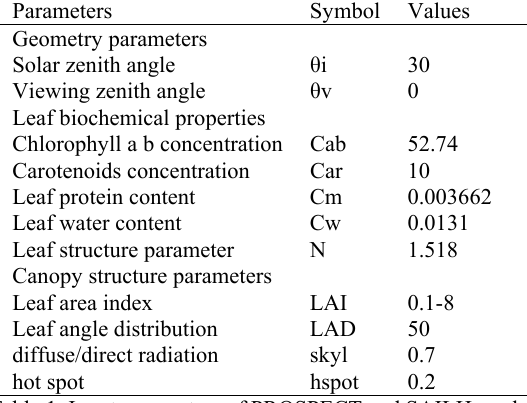
Table 1. Input parameters of PROSPECT and SAILH model.